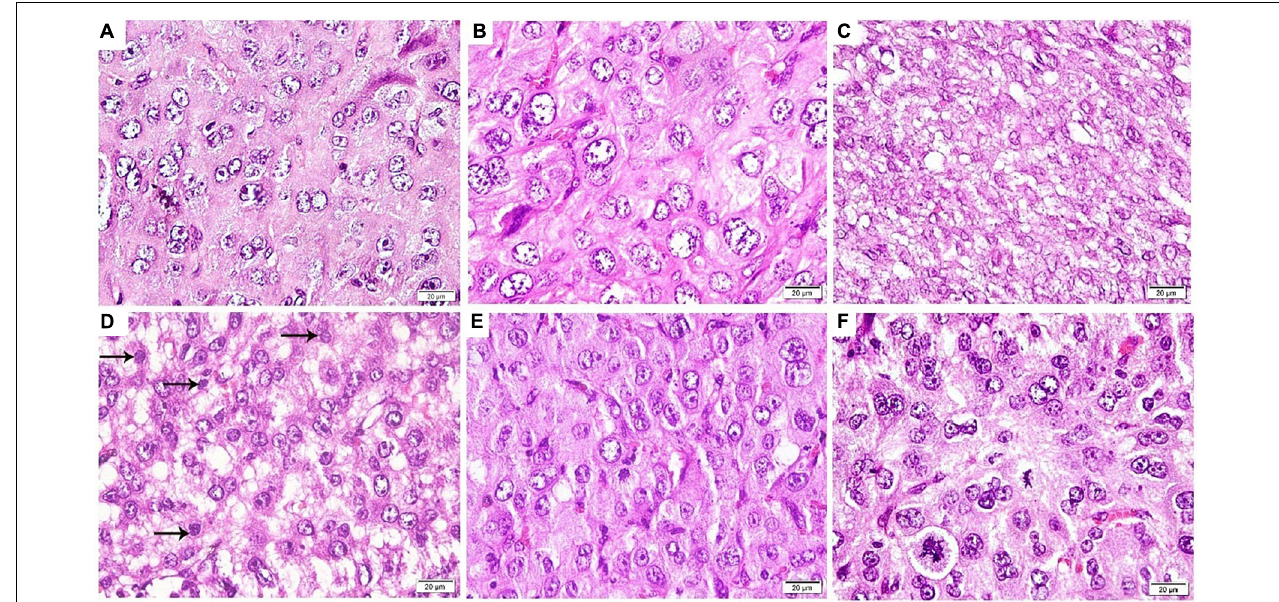
FIGURE 6 | Photomicrograph of an antimesometrial region of the rat uteri at the 8th day of pregnancy (H&E × 400): (A) Control and (B) Control-D400 revealing different sized rounded decidual cells illustrating eosinophilic cytoplasm, vesicular nuclei, and numerous prominent nucleoli. (C) DEF displaying an impaired differentiation of stromal cells into decidual cells. (D) DEF-D400 illustrating alternating decidual cells and impaired differentiated stromal cells (arrows) into decidual cells. (E) DEF-D4000 and (F) DEF-D10000 revealing an obvious differentiation of stromal cells into different sized rounded decidual cells. Scale bar: 20 µ